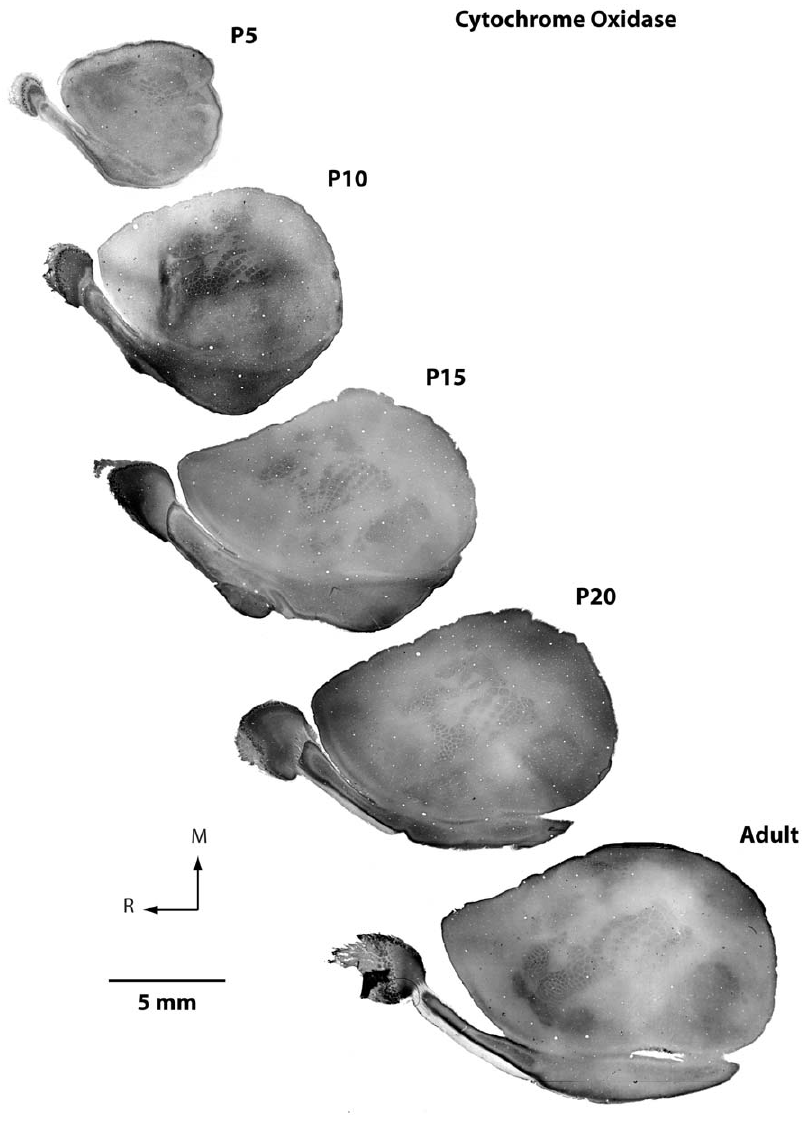
Figure 5. Appearance of cytochrome oxidase stained cortical tissue across development. Photomicrographs of cortex that has been flattened, sectioned tangentially and then stained for CO in P5 (top) through adult (bottom) subjects. Portions of the primary sensory areas, especially somatosensory cortex, are visible in all sections, but individual sections do not show all of the boundaries of a field. Images were imported into Adobe Photoshop and levels were adjusted to increase contrast. In all photomicrographs, medial is to the top and rostral is to the left.